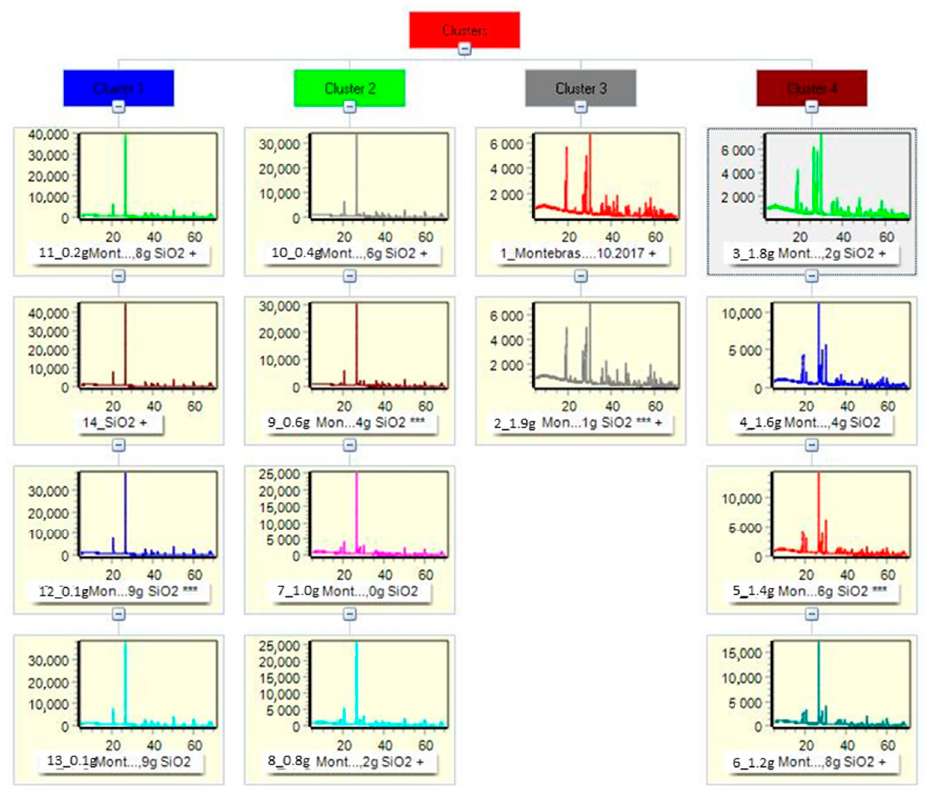
Figure 19. XRD patterns of quartz–montebrasite mixtures forming the four relevant calculated